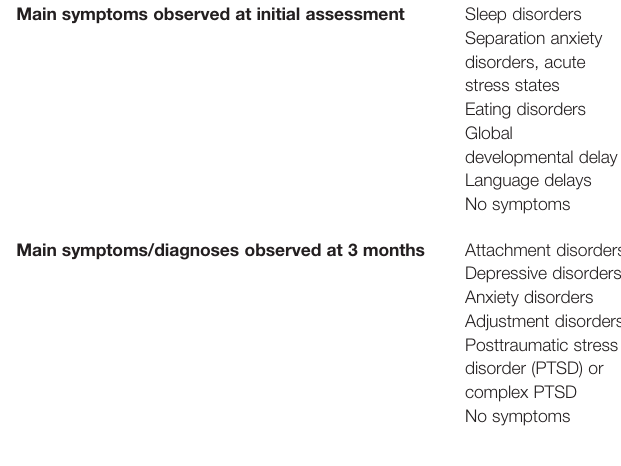
TABLE 3 | List of symptoms observed among the 32 child returnees by the Avicenne